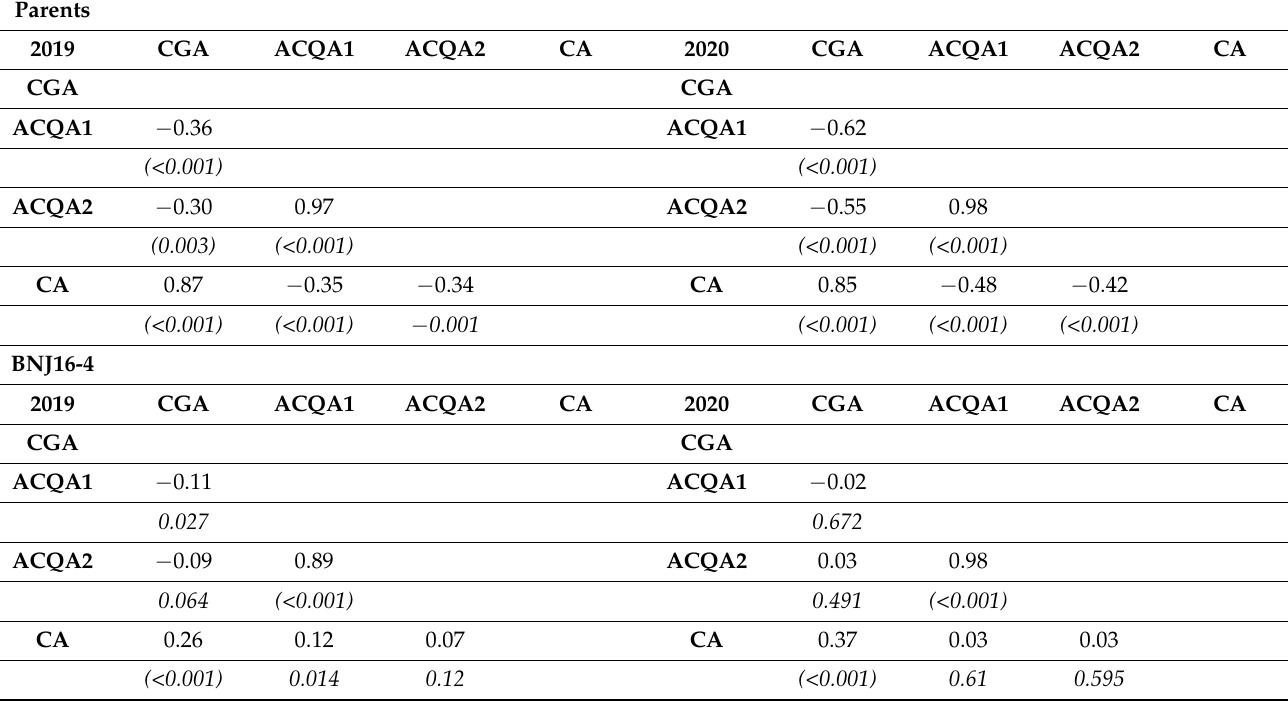
Table 4. Correlational data for the Parents and Grandparents and the BNJ16-4 population be- tween tested compounds. Italicized numbers indicate the p -values of the observed correlations. p -value < 0.05 was considered significant. Correlations were ranked as weak (|<0.3|), moderate (|0.3–0.7|), or strong